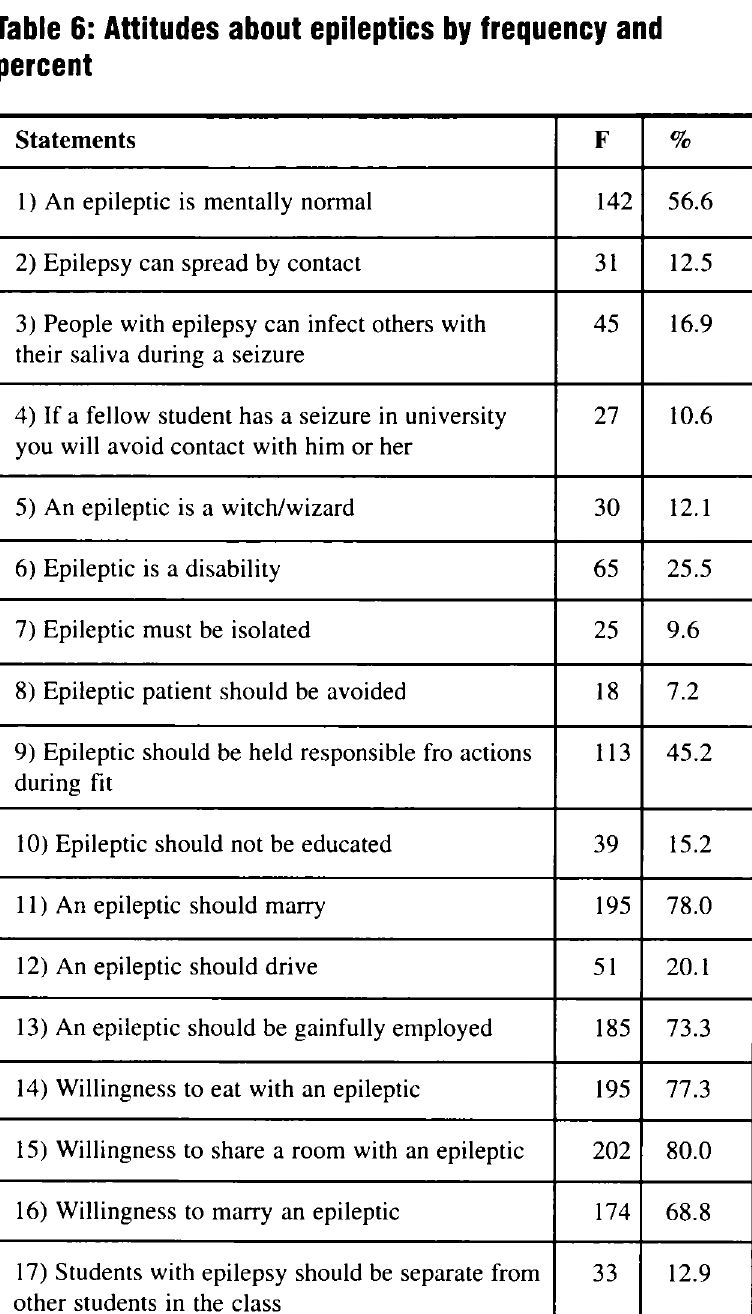
Table 6: Attitudes about epileptics by frequency and